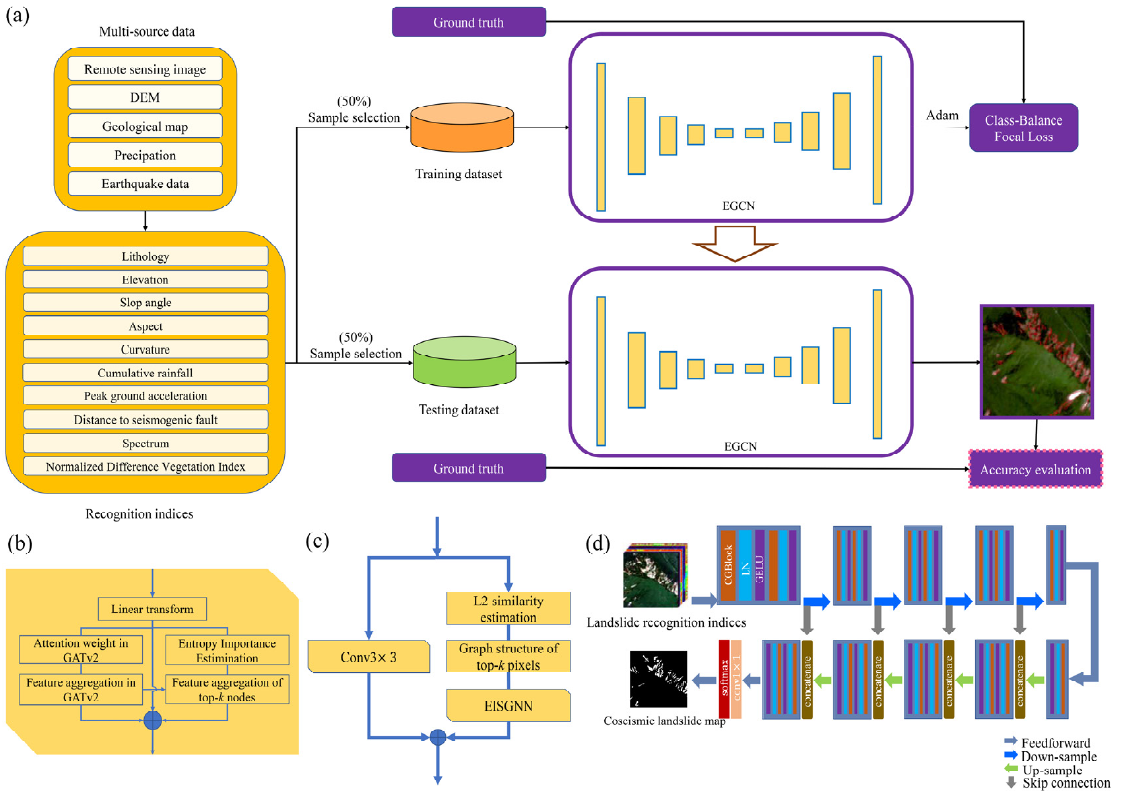
Figure 2. Technology flow chart of coseismic landslide recognition. ( a ) Framework diagram for landslide identification. ( b ) Structure of the graph neural network EISGNN. The left branch indicates the GATv2 attention aggregation process, and the right branch exhibits the selective aggregation strategy based on the top- k entropy importance coefficients. ( c ) Structure of CGBlock integrating the CNN and GCN branches. ( d ) General structure of EGCN with CGBlock as a basic block; the detailed structure of the EGCN is introduced in Section